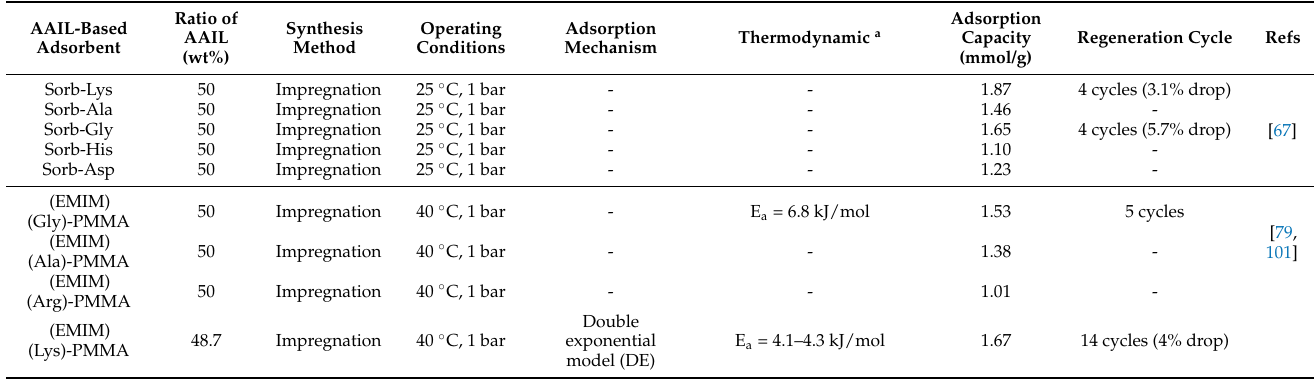
Table 7. Amino acid ionic liquid (AAIL)-based adsorbents (from 2012 to 2022).